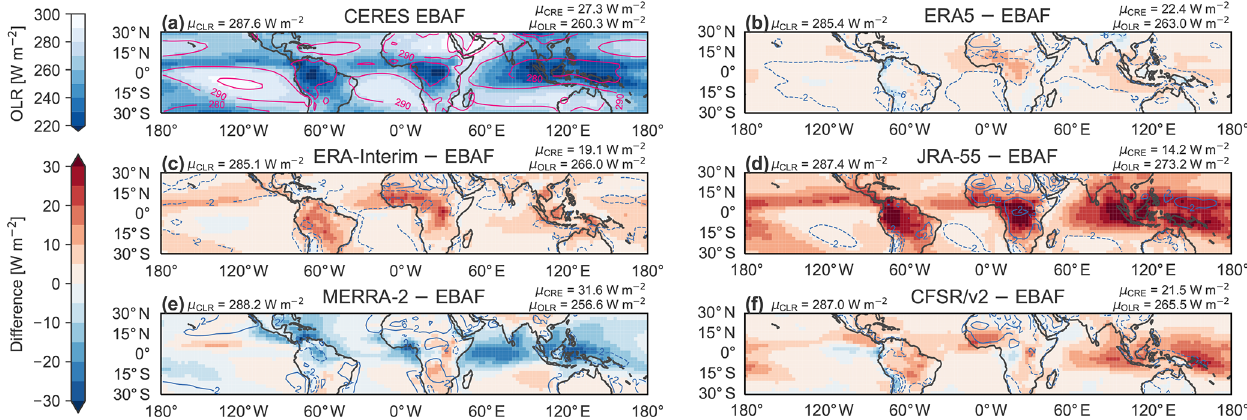
Figure 5. Climatological mean spatial distributions of all-sky outgoing long-wave radiation (OLR; shading) and clear-sky outgoing long- wave radiation (CLR; contours at intervals of 10Wm − 2 ) for (a) CERES EBAF over 2001–2014. Differences relative to CERES EBAF for the same period are shown for (b) ERA5, (c) ERA-Interim, (d) JRA-55, (e) MERRA-2, and (f) CFSR/CFSv2 (abbreviated CFSR/v2). Contours in (c) through (f) cover the range within ± 10Wm − 2 at intervals of 4Wm − 2 . Tropical-mean (30 ◦ S–30 ◦ N) values of OLR and CLR based on each product are shown at the upper-right and upper-left corners, respectively, of the corresponding panel. Tropical-mean values for the long-wave cloud radiative effect (LWCRE = CLR − OLR) are listed above those for OLR.